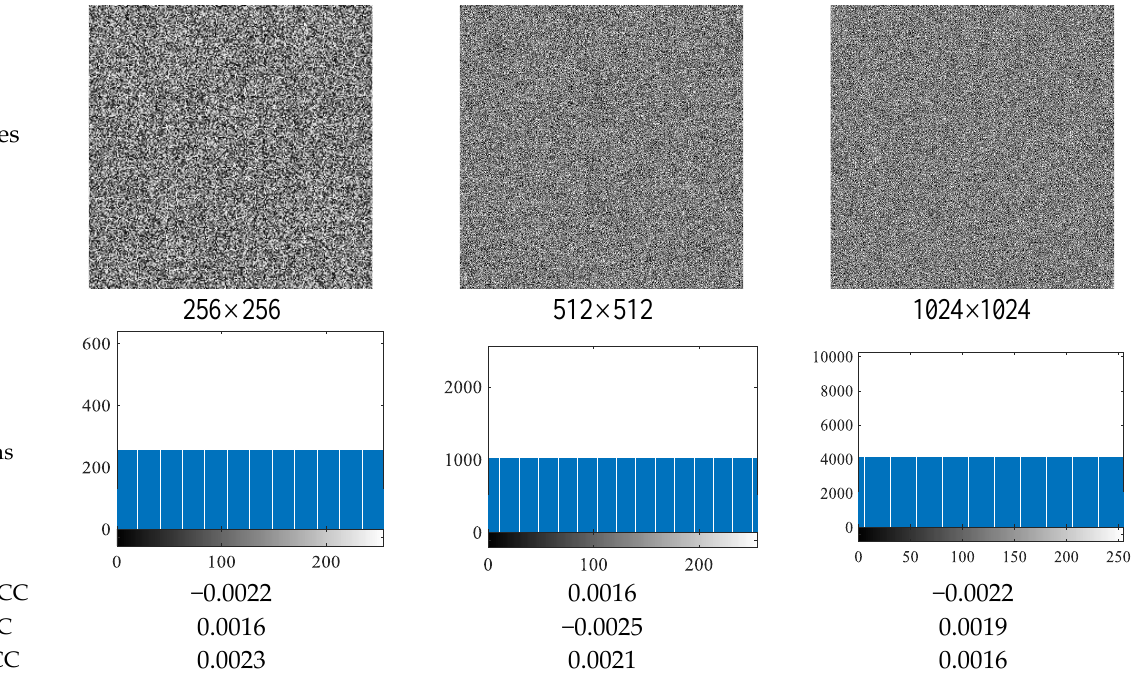
Figure 10. Key images (KIs) of different sizes generated by the proposed method.